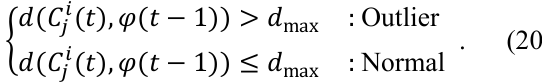
Table 1. Comparing the centralized and distributed approaches for communication overhead